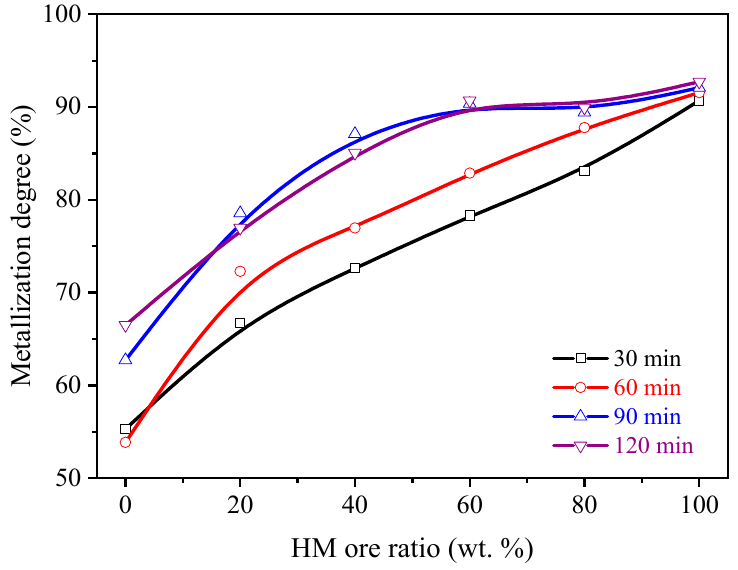
Figure 7. Effect of ratio of high-manganese iron ore (HM ore) in blend on metallization degree of reduced pellets (reducing at 1050 °C with C/Fe mass ratio of 1.5).